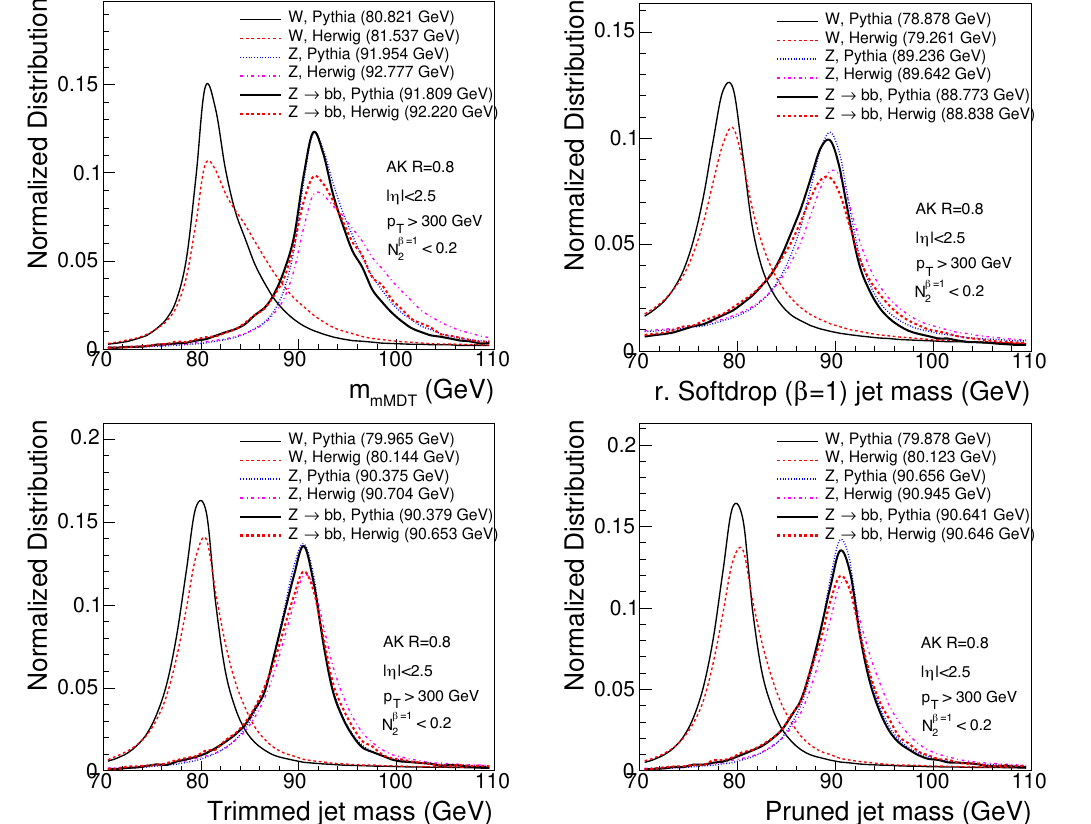
Figure 9 . Jet mass distribution of W , Z and Z ! b (cid:22) b jets in pythia and herwig with p T larger than 300 GeV and N (cid:12) =1 < 0 : 2 for four di(cid:11)erent grooming algorithms. (top left) mMDT with 2 the angular exponent (cid:12) = 0, soft cuto(cid:11) threshold z cut = 0 : 1, and characteristic radius R 0 = 0 : 8. (top right) recursive softdrop [56] with the angular exponent (cid:12) = 1, soft cuto(cid:11) threshold z cut = 0 : 1, characteristic radius R 0 = 0 : 8, and the number of iterations N set to in(cid:12)nity. (bottom left) trimming [57] with subjet size of R sub = 0 : 2 and f cut=0 : 03 . (bottom right) pruning [58] with the soft threshold parameter z cut = 0 : 1 and angular separation threshold of (cid:1) R > m jet =p T,jet